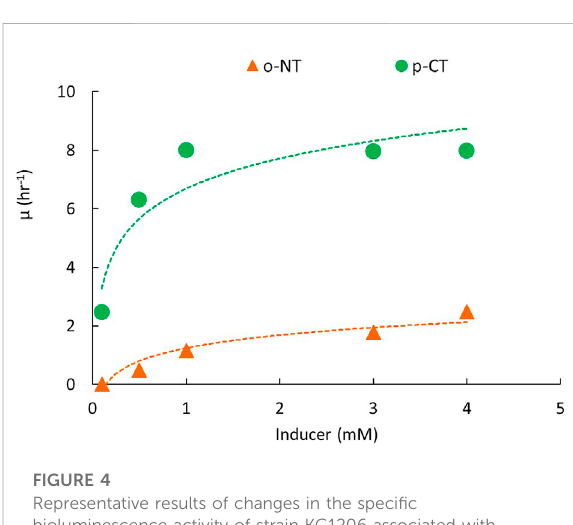
FIGURE 4 Representative results of changes in the speci fi c bioluminescence activity of strain KG1206 associated with changes in the concentrations of p -CT and o -NT. Figure 4 shows two representative results of the KG1206 recombinant strain on changes in “ μ ” in terms of the concentration inducer ( p -CT and o -NT). The strains exposed to